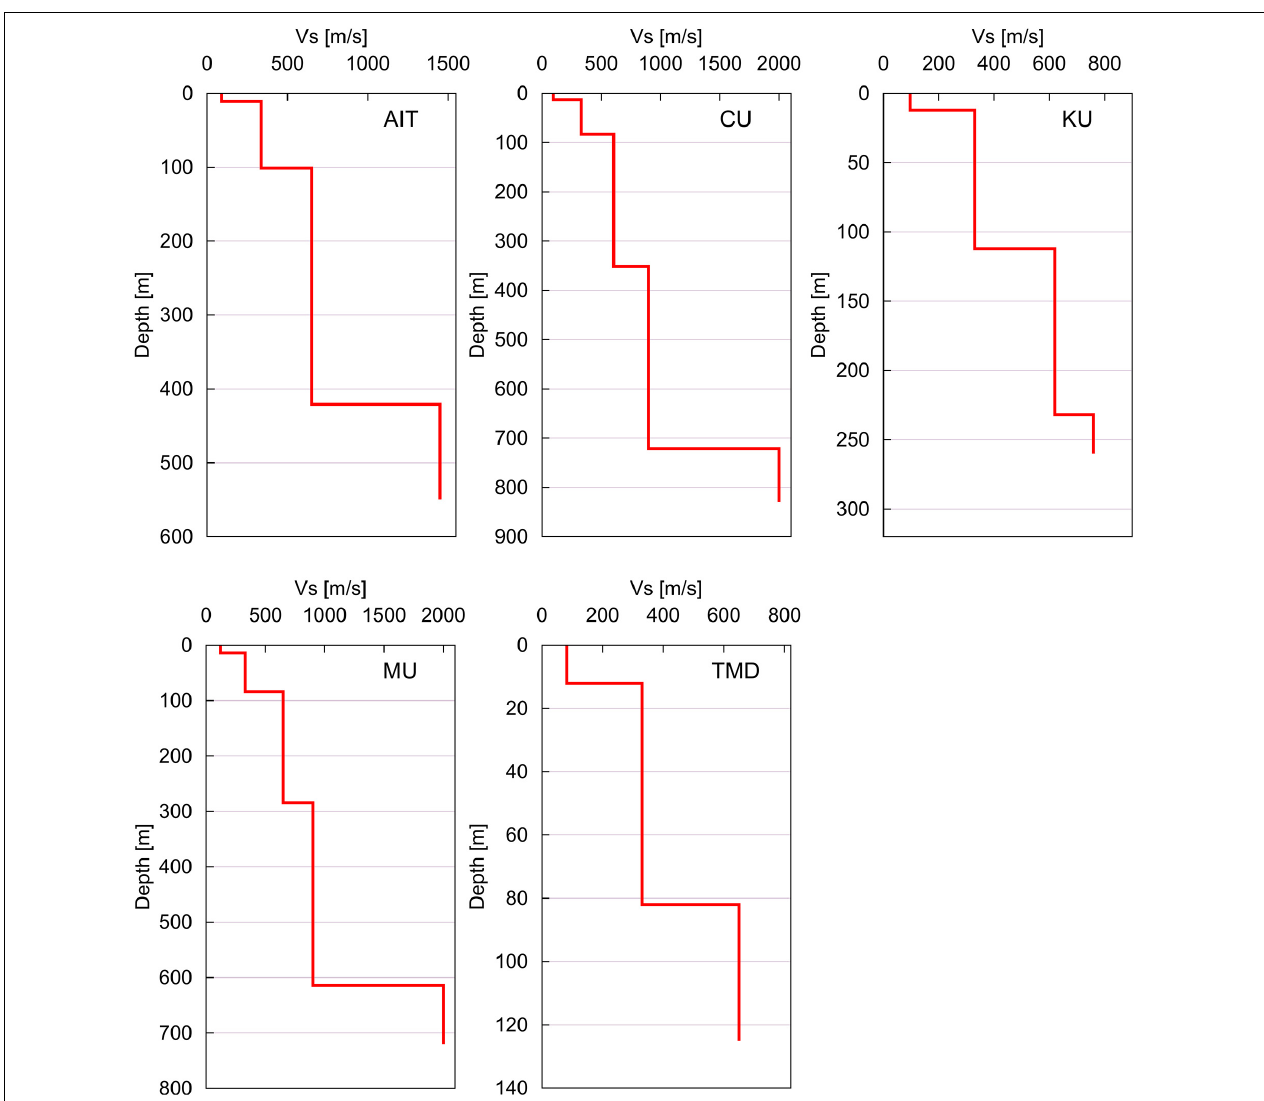
FIGURE 9 | Velocity profiles from inversion of the dispersion curves shown in Figure 8 .